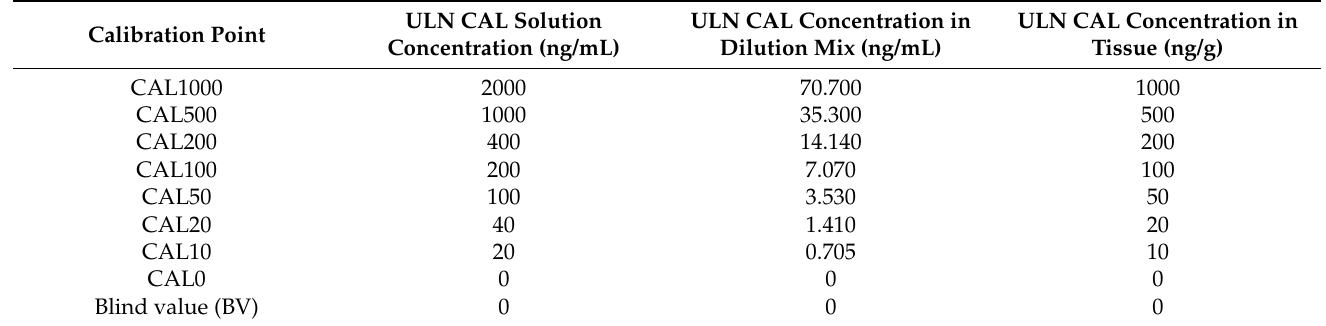
Table 1. Concentrations of the calibration standard (CAL) solutions of ulixertinib (ULN) in solutions and in spiked biological